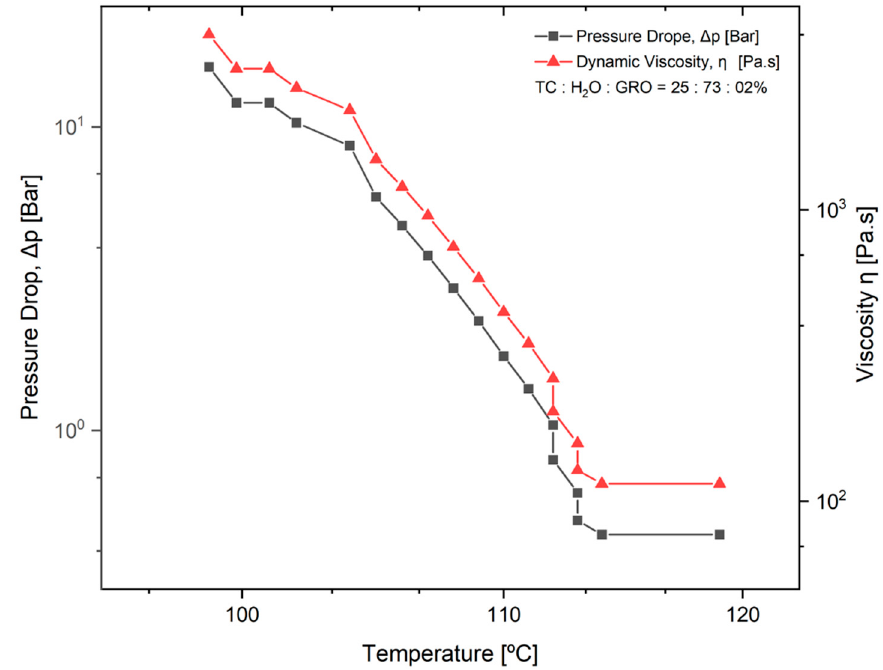
Figure 3. Pressure drop in the tip of the needle ( ∆ p needle tip ) as a function of temperature and dynamic viscosity of the material. The normal distribution of the model was verified for each group using the Kolmogorov-Smirnov test. The adjusted R-square (R-sq (adj)) for the model was 0.941.